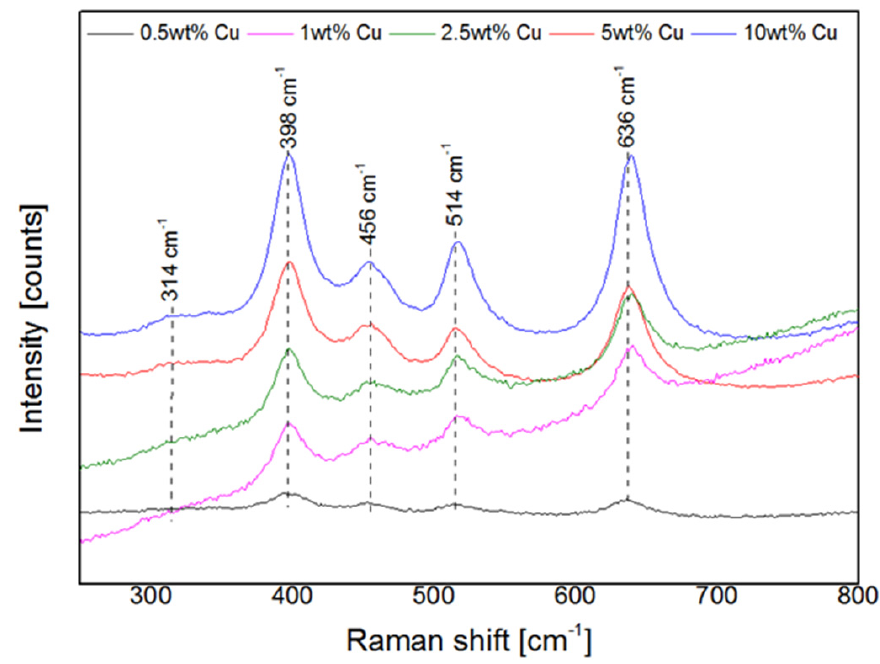
Figure 2. Raman patterns of Cu-MOR catalysts with varying copper loadings.